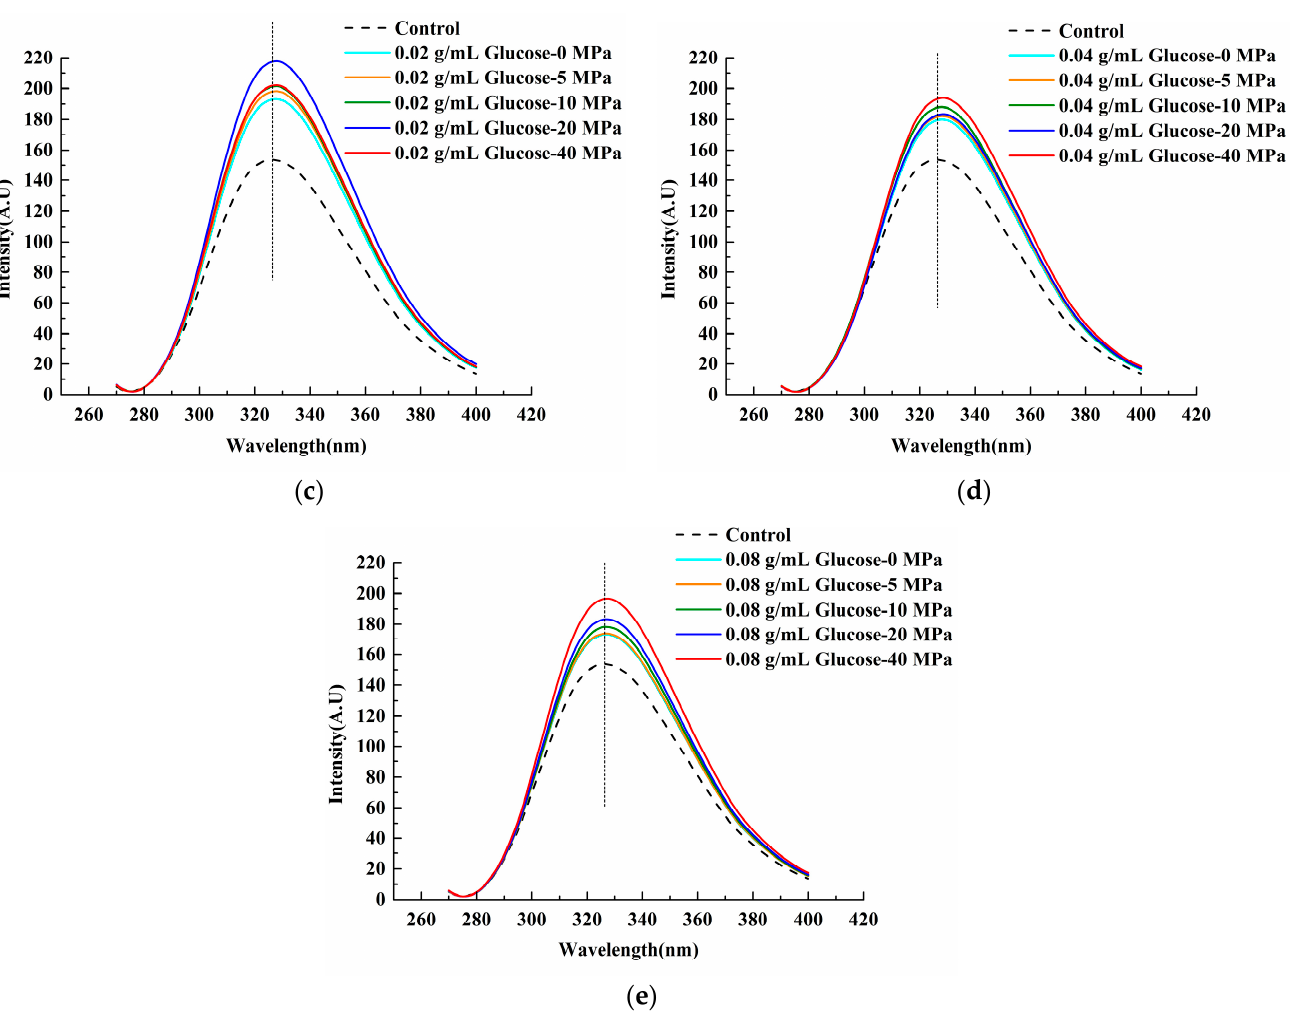
Figure 1. The intrinsic fluorescence spectra of LWE under different homogenization pressure treat- ment and glucose concentrations. ( a – e ) Presented the intrinsic fluorescence spectra of the LWE after adding 0 g/mL, 0.01 g/mL, 0.02 g/mL, 0.04 g/mL, and 0.08 g/mL glucose in turn.